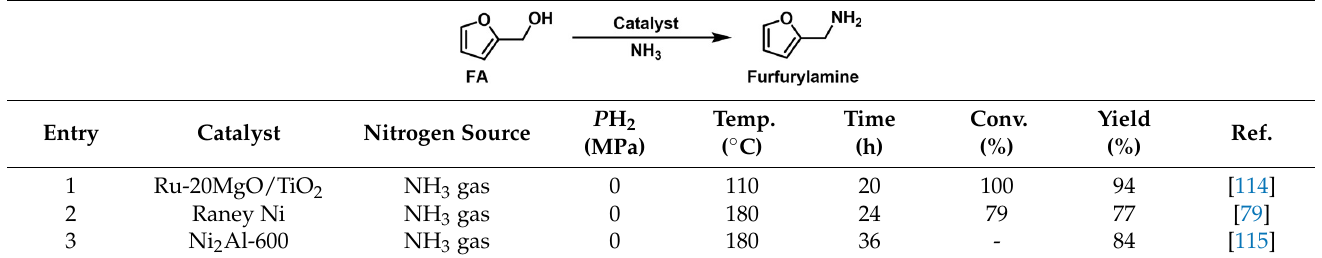
Table 7. Hydrogen-borrowing amination of FA with NH 3 .